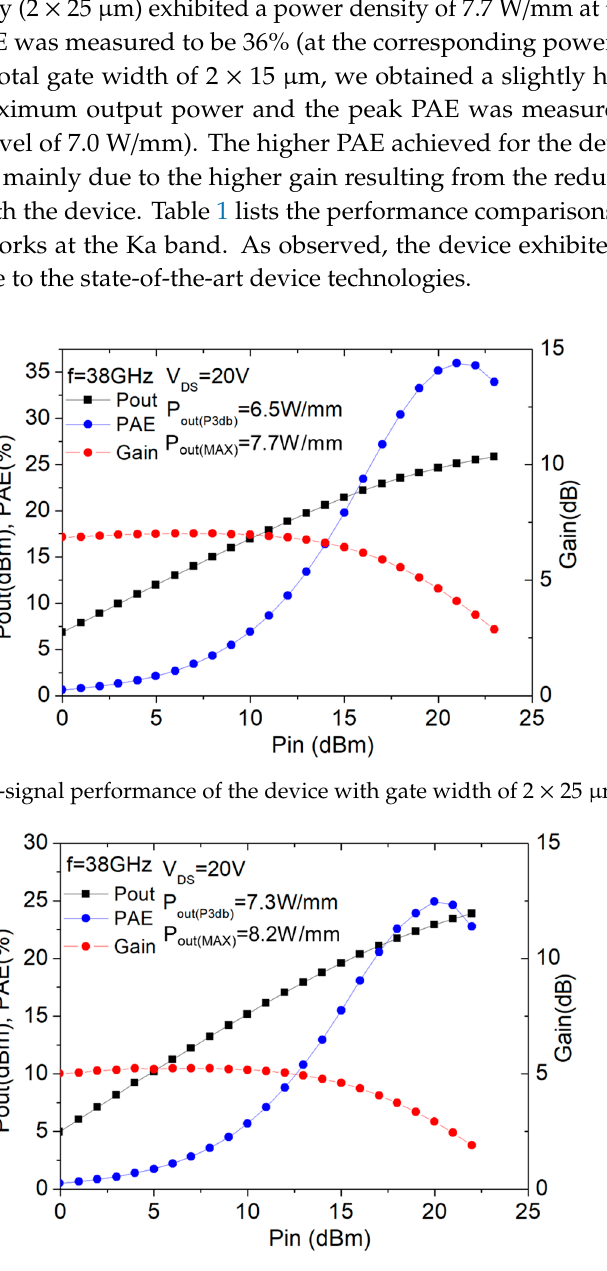
Figure 13. Large-signal performance of the device with gate width of 2 × 15 µ m at 38 GHz. Table 1. Power performance comparison of the Cu metallization with other reports.